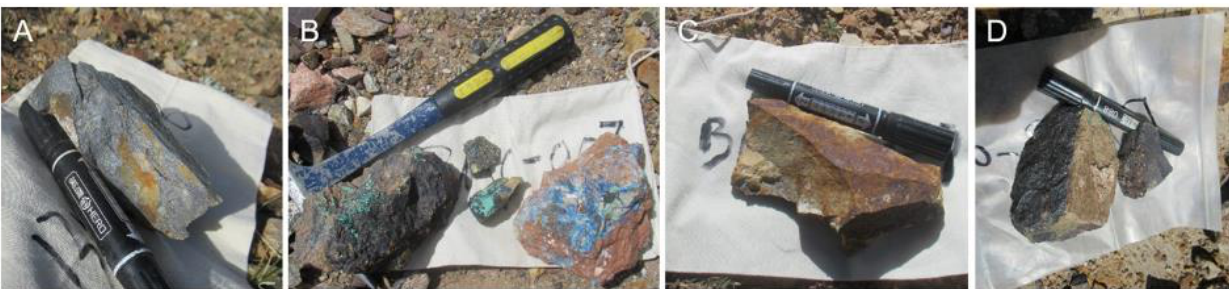
Figure 16. Prospectivity maps showing different potential areas delineated by the black line.